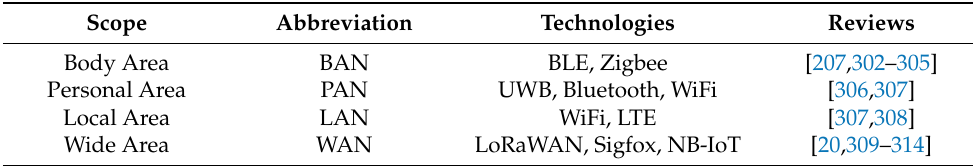
Table 4. Communication technologies for PHY